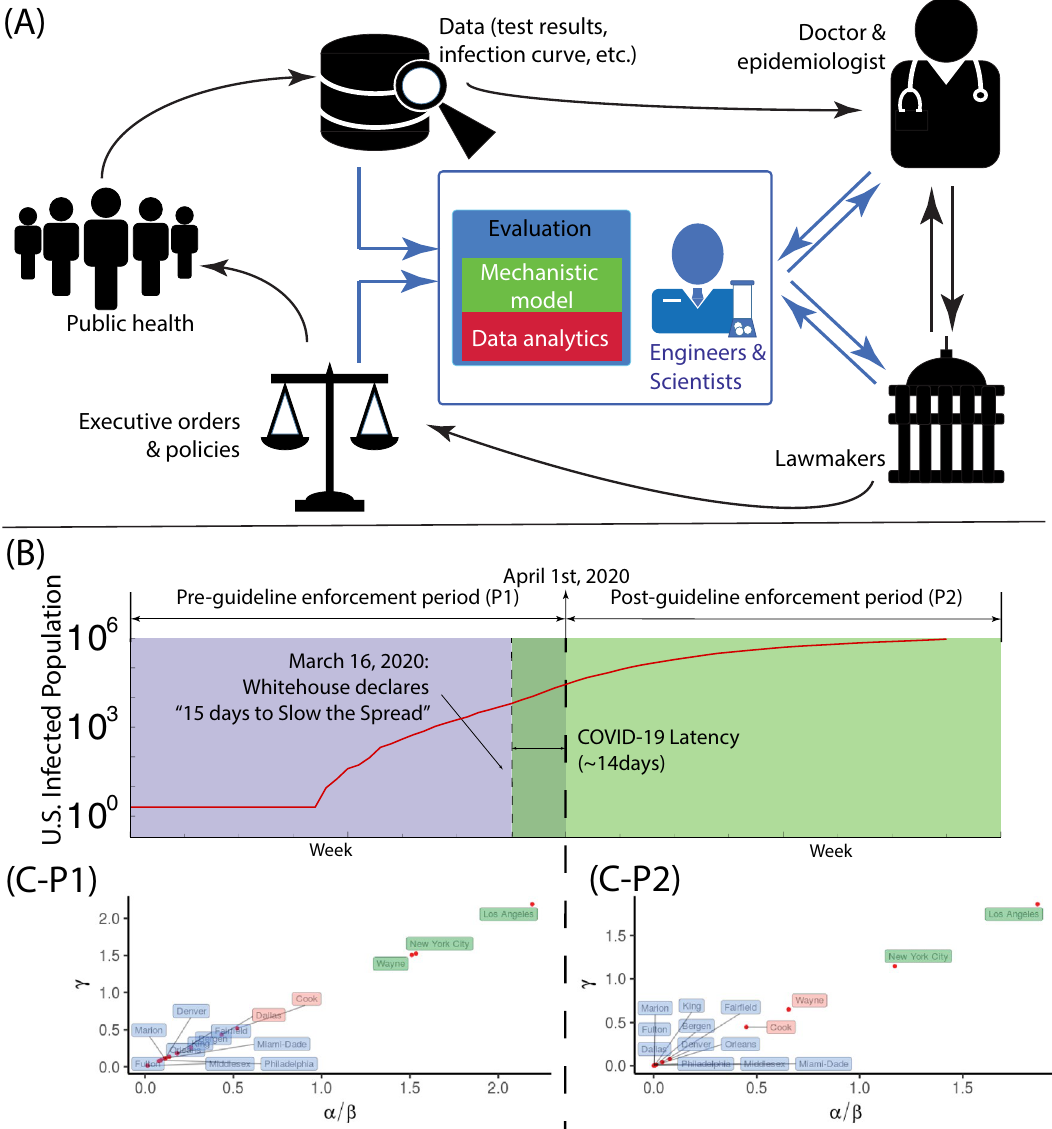
Figure 1. Parametric study on coronavirus infection in United States. ( A ) By incorporating both mechanistic modeling and data analysis (in blue) into the traditional workflow of the policy making (in black), a refreshed framework forms a three-way communication among expert (doctor/epidemiologist), engineers/scientists and lawmakers, thus improving the implementation of health policies against the infectious disease. ( B ) The timeline of total population with COVID-19 positive in conjunction with the policy of “15 Days to Slow the Spread” in the United States, in which the infection period is divided into the pre-guideline enforcement period (P1) and the post-guideline enforcement period (P2). ( C ) The phase space in terms of α/β and γ is plotted for the leading infected counties in first fifteen states: P1 duration and P2 duration. The phase space is segregated as three regions: ‘severe’ (labeled as green; α/β ∈ ( 1.0, ∞ ) ), ‘moderate’ (labeled as red; α/β ∈ [ 0.4, 1.0 ] ), and ‘mild’ (labeled as blue; α/β ∈ ( 0, 0.4 )